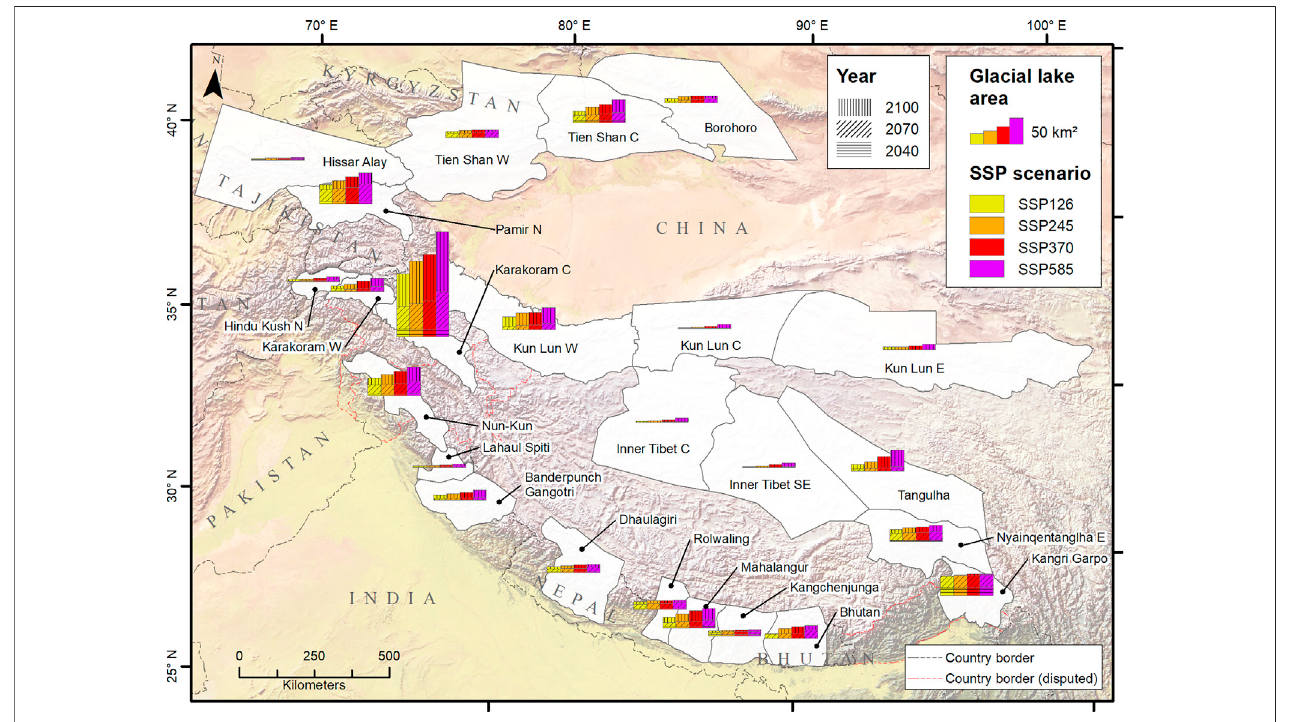
FIGURE4| Increaseofglacial lakeareain HMAunderfour SSPscenariosuptothree points intime during the 21st century. SSPscenarios are color-coded, years are indicated by different dashes. Regions with < 5 km 2 of lake area increase in 2100 (SSP585) are excluded for reasons of clarity.